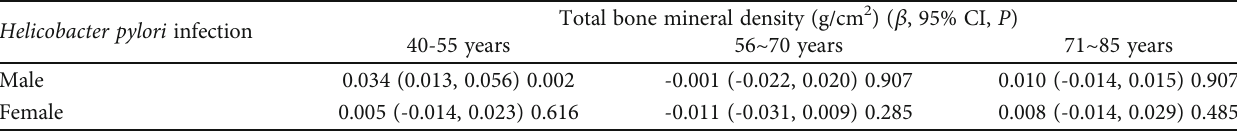
Table 3: Total bone mineral density strati fi ed by race and